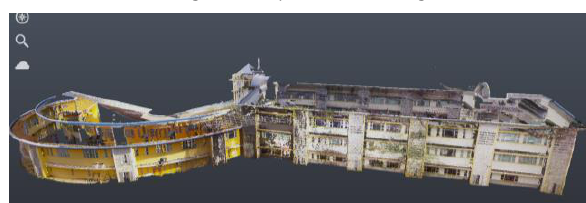
Figure 14 Top view of